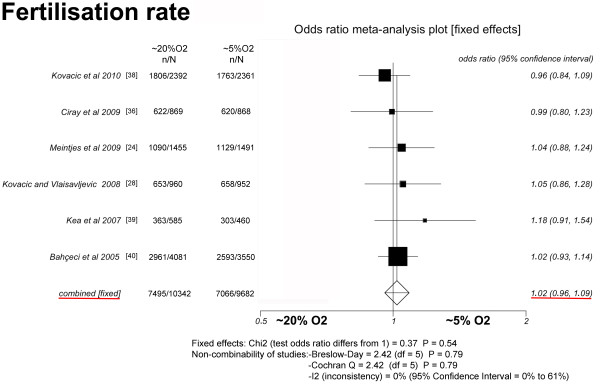
Fixed-effect model. Forest plot for fertilisation rate.